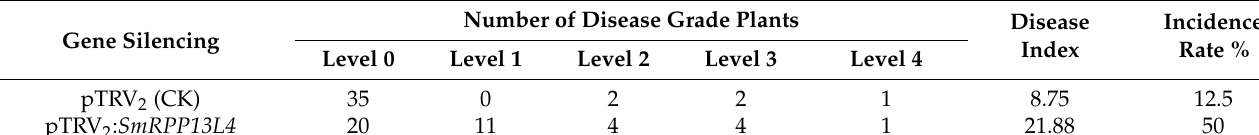
Table 1. Statistics of bacterial wilt after silencing SmRPP13L4 gene.